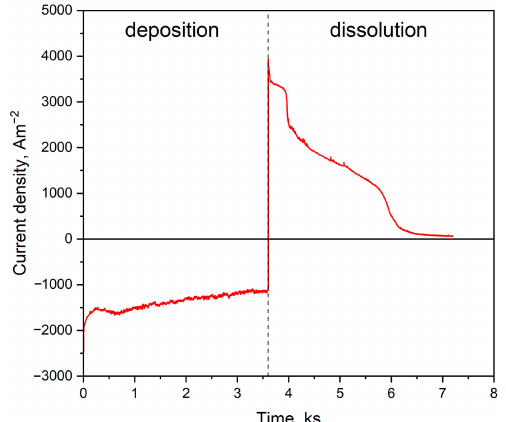
Figure 2. Current density-time curves of the Al deposition at − 1.9 V and Al dissolution at − 0.5 V in NaCl-KCl-3.5 mol%AlF 3 melt at 900 ◦